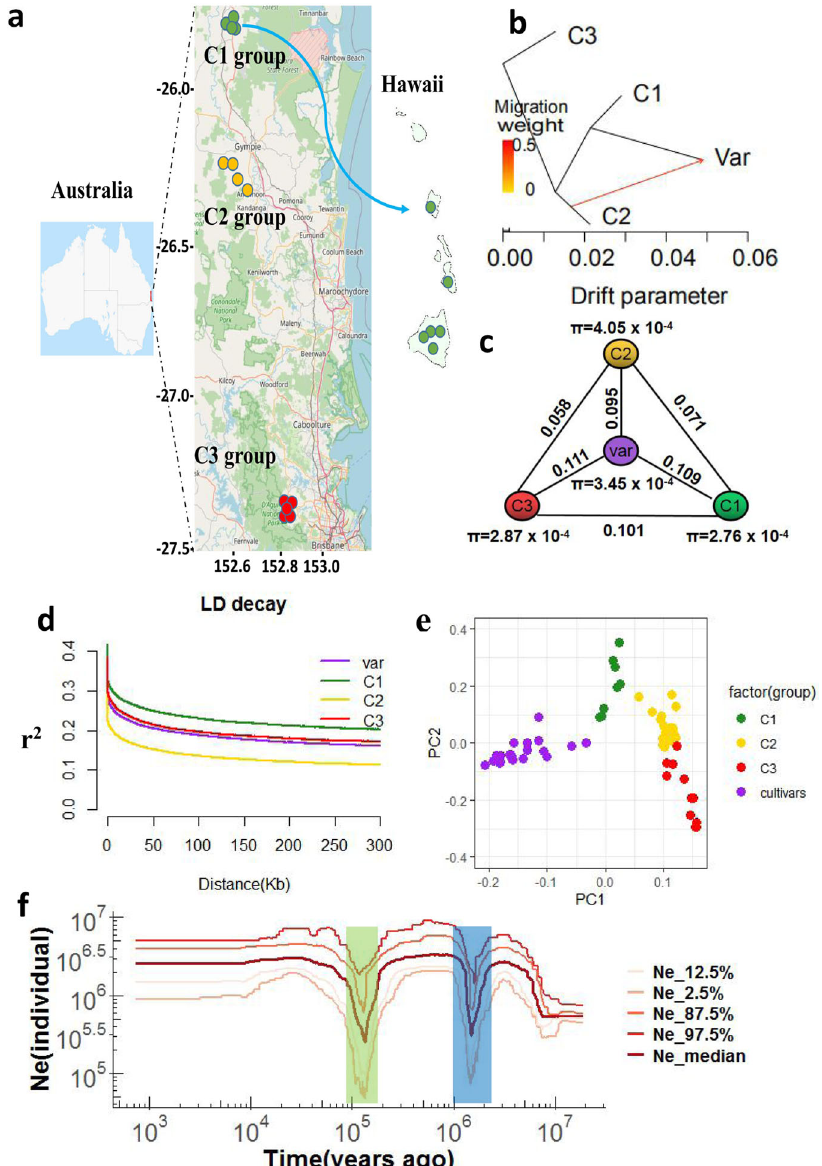
Fig. 5 Geographic distribution and drift paths of wild to varieties. a Genetic- fl ow paths visualized on the map, the map was based on OpenStreetMap (Base map © OpenStreetMap, see https://www.openstreetmap.org/copyright) b Gene-drift in wild groups and varieties. c F ST and π values of each groups. d LD decay for three wild groups (C1 – C3) and varieties of M. integrifolia . e PCA clustering of three wild groups (C1 – C3) and varieties of M. integrifolia . f Effective population size ( N e ) history estimated using ANGSD using g (generation time) = 8 years and m (neutral mutation rate per generation) = 4.175*10 − 9 and plot by software Stairway plots with 200 bootstrap iterations. Source data underlying d , f are provided as a Source Data fi